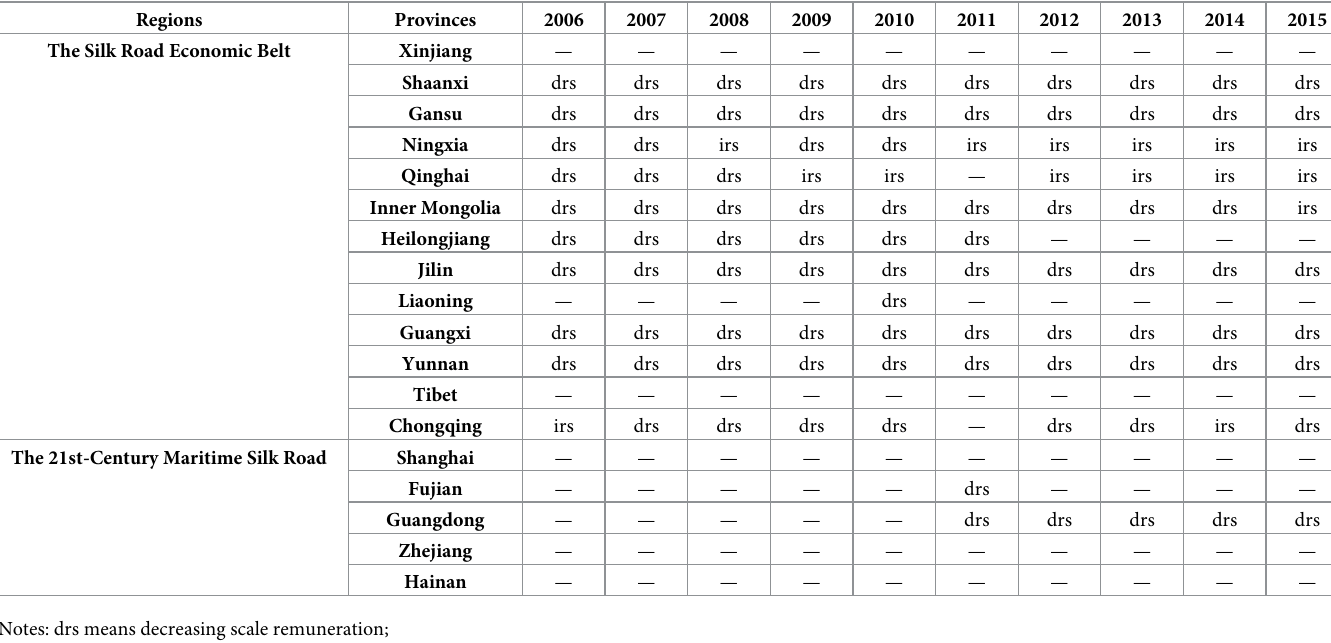
Table 6. Increase/decrease in economies of scale of agricultural carbon emissions of key provinces along the B&R, 2006–2015.